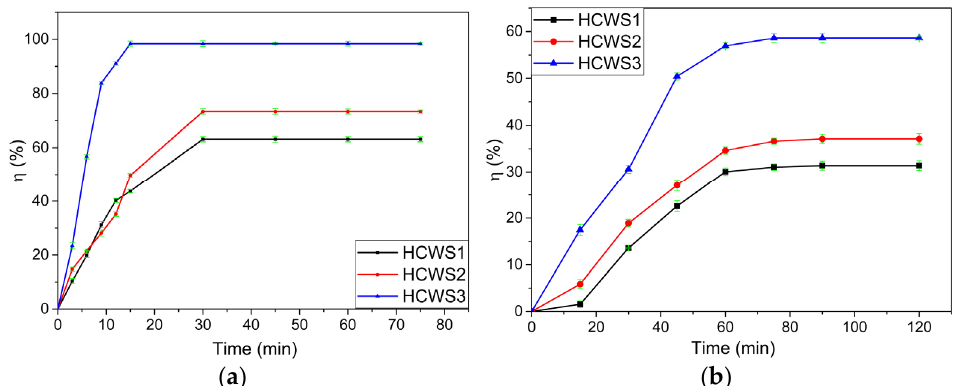
Figure 3. Pollutant retention efficiency for HCWS eco-materials. ( a ) MB, concentration of 5 mg/L; ( b ) PRM, concentration of 50 mg/L. ( b ) PRM, concentration of 50